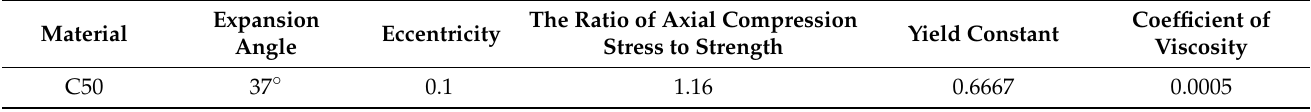
Figure 20. Material constitution of concrete. Table 9. Concrete material parameters. Material